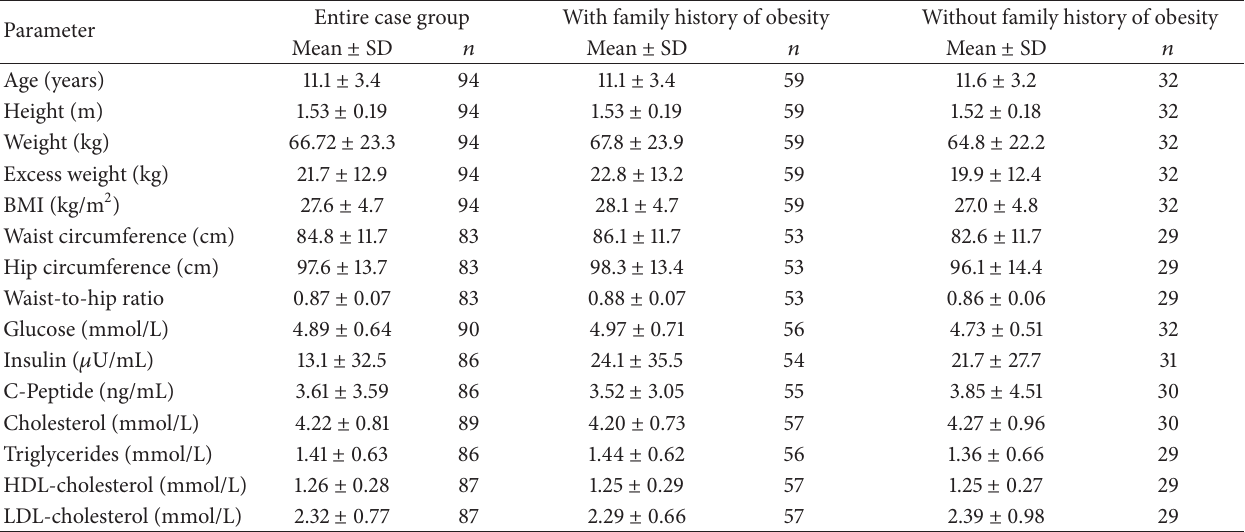
Table 2: Anthropometric and clinical parameters of the case group.